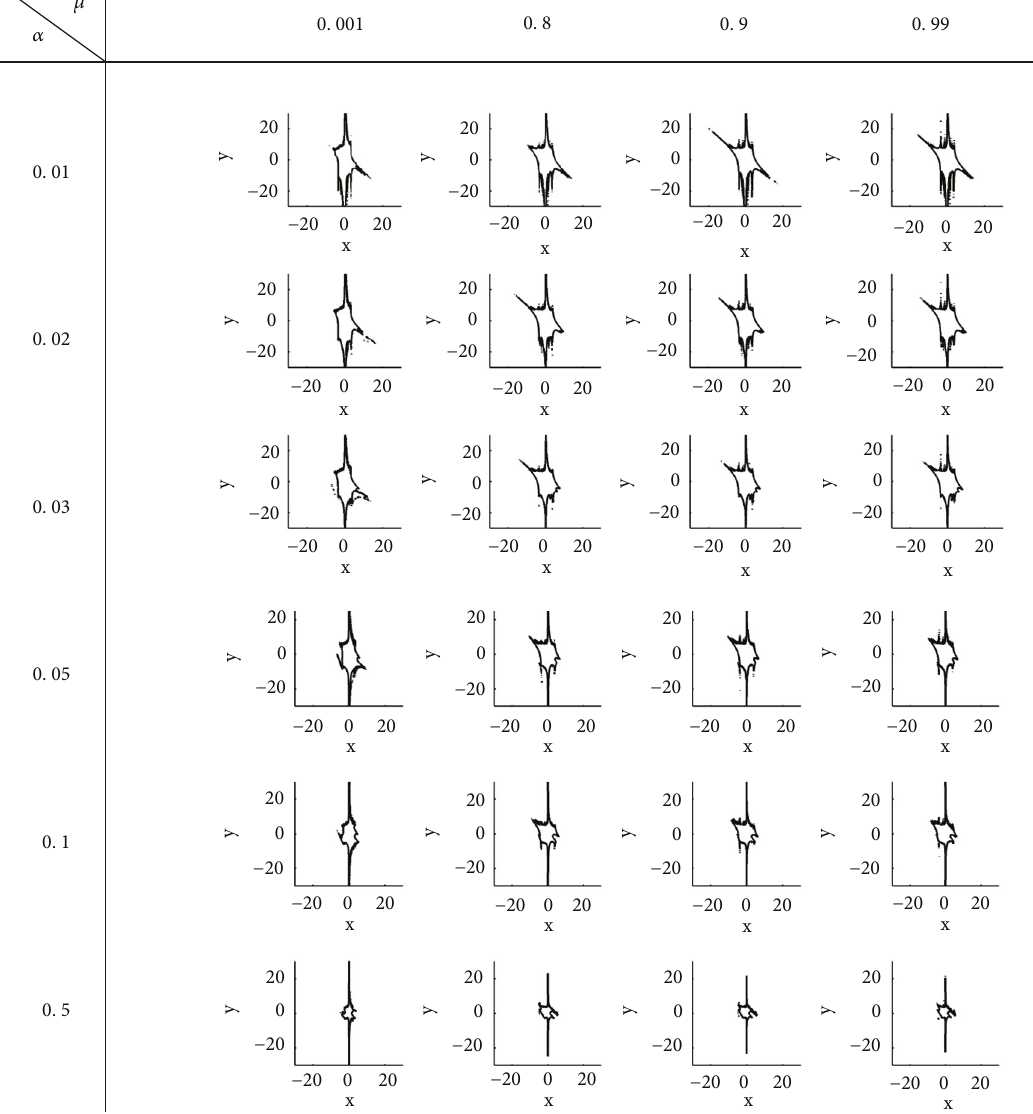
Figure 3: The change of Julia sets of the controlled system (16) when ( a )𝛼 = 0.01; ( b )𝛼 = 0.02; ( c )𝛼 = 0.03;( d )𝛼 = 0.05;( e )𝛼 = 0.1;( f )𝛼 = 0.5 and 𝜇 = 0.001, 0.8, 0.9, 0.99